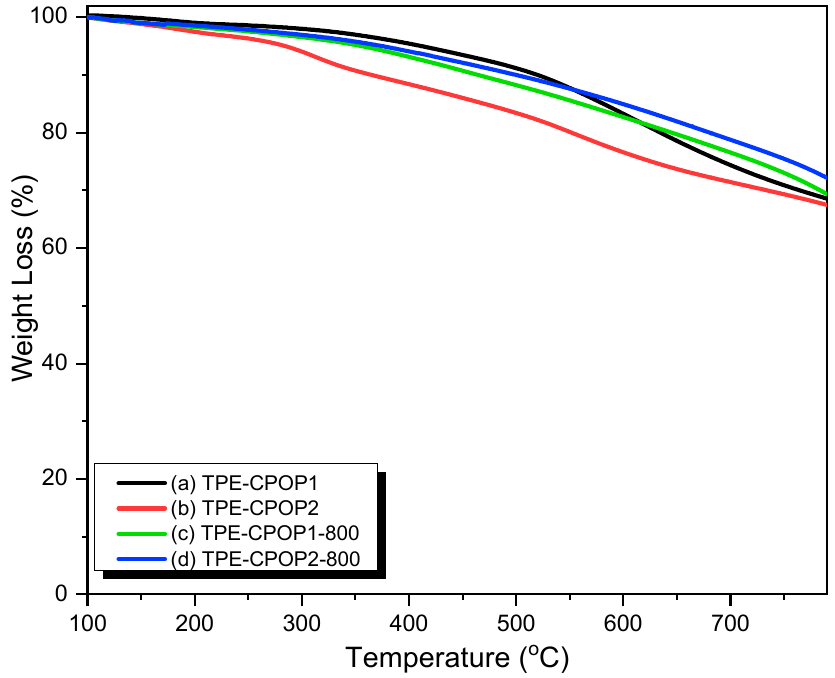
Figure 3. TGA diagram of ( a ) TPE-CPOP1 and ( b ) TPE-CPOP2, ( c ) TPE-CPOP1-800, and ( d ) TPE- CPOP2-800.